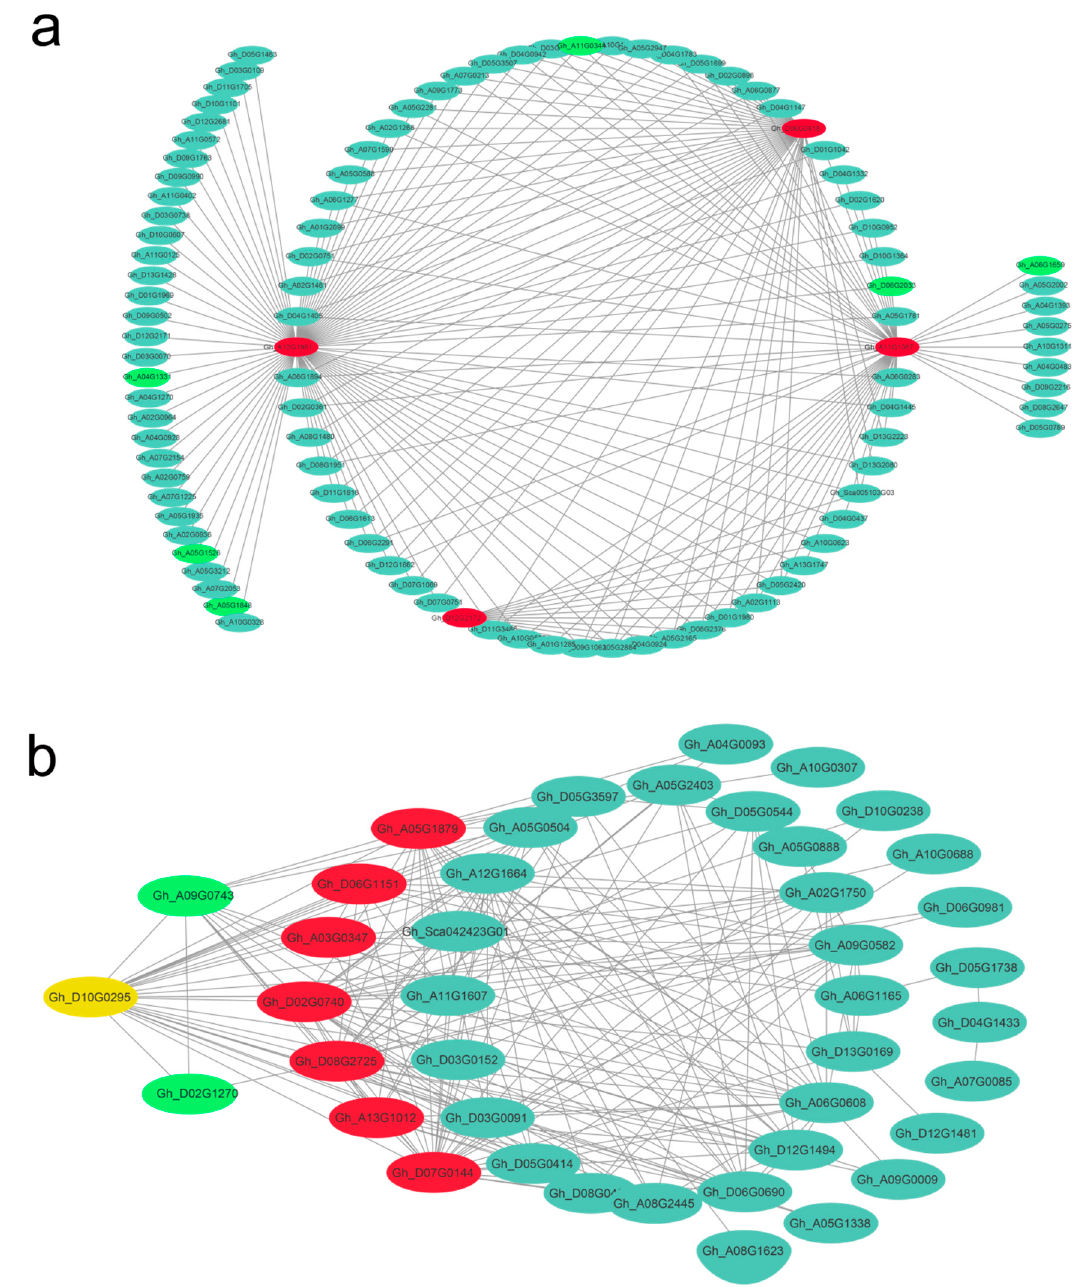
Figure 8. Correlation networks for the dark red and violet modules. Hub genes are indicated by red circles; green circles indicate transcription factors; yellow circles indicate both a hub gene and a transcription factor.